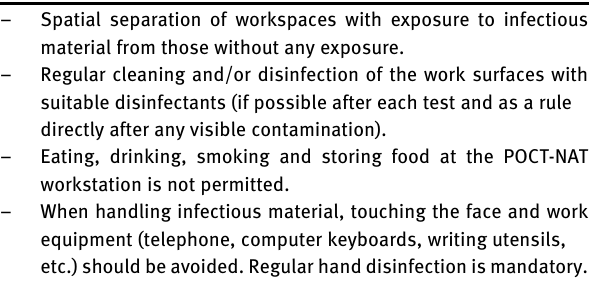
Table  : Hygiene requirements – basic rules.